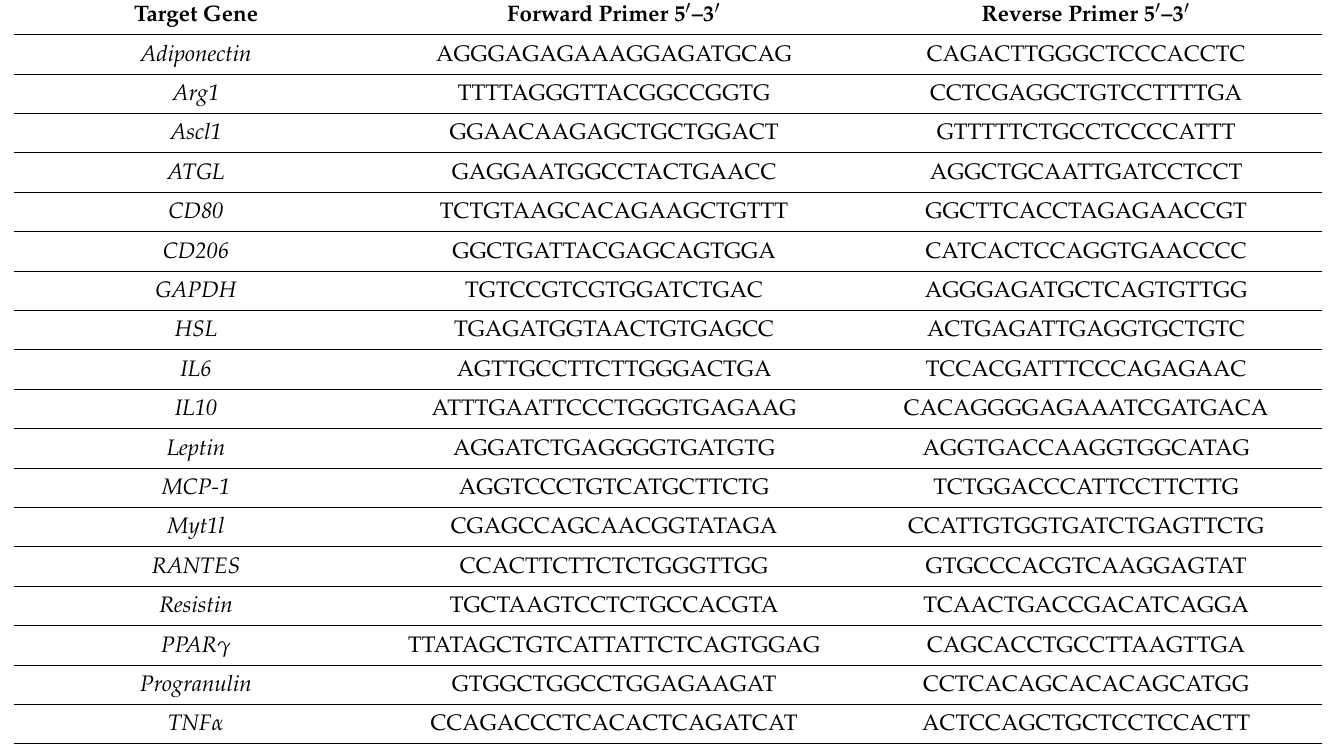
Table 3. Primer pairs for gene expression analysis in murine adipocytes and adipose tissue. Target Gene Forward Primer 5 (cid:48) –3 (cid:48) Reverse Primer 5 (cid:48) –3